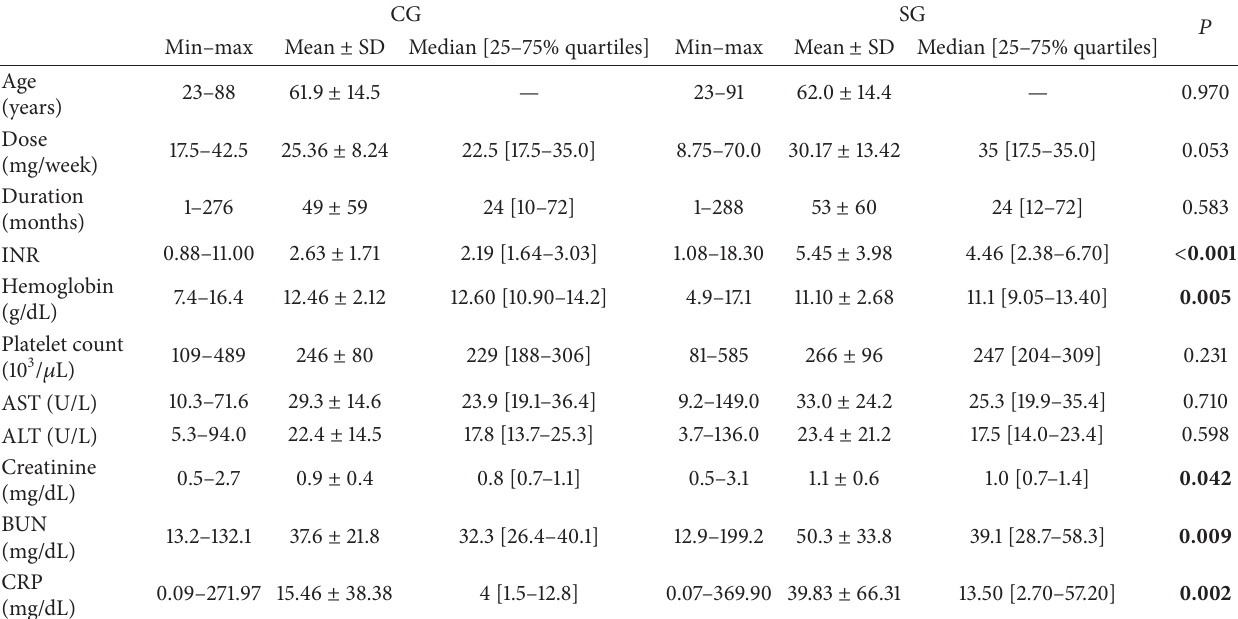
Table 2: Doseand durationof warfarin useand laboratory resultsof 128 patients usingwarfarin with bleeding-related (SG)and non-bleeding- related (CG) reasons for their emergency department visits.